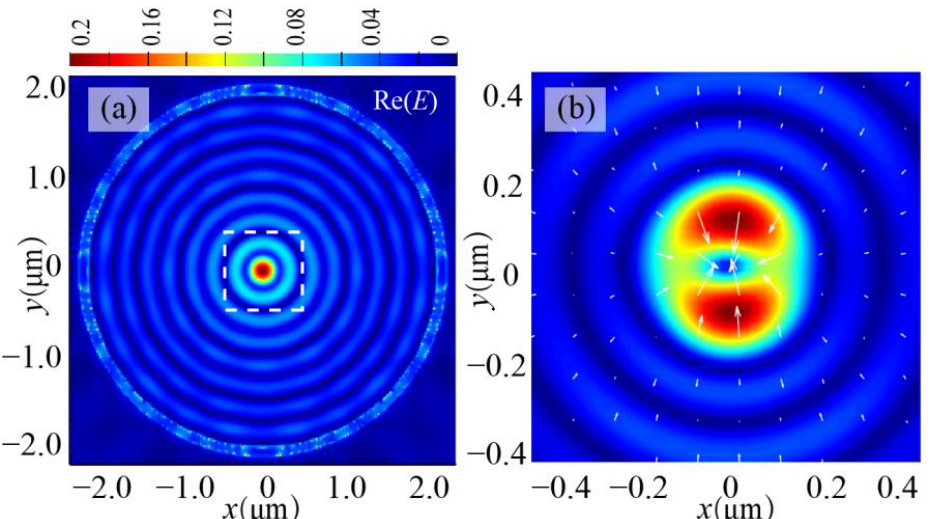
Figure 4. Electric field distribution ( a ) and optical force distribution ( b ) at the center of the annular slit excited by radially polarized light.